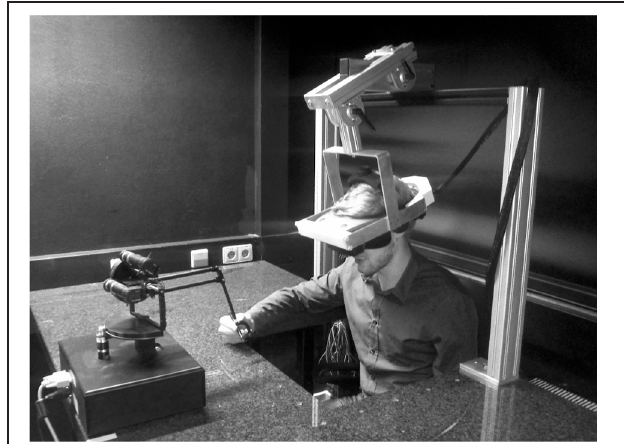
FIGURE 15 | Photograph of the experimental apparatus. The subject operates a Sensable (cid:2) Phantom (cid:2) Premium 1.5 High Force manipulandum and receives stereoscopic 3D visual feedback through an NVIS (cid:2) nVisor ST50 head-mounted display.